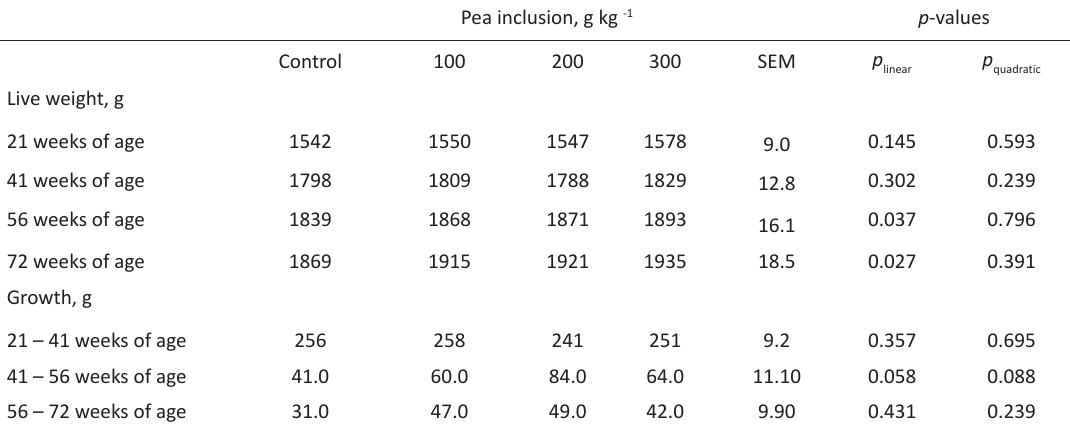
Table 5. The effects of dietary inclusion level of peas on the mean live weight and change in live weight of laying hens 1